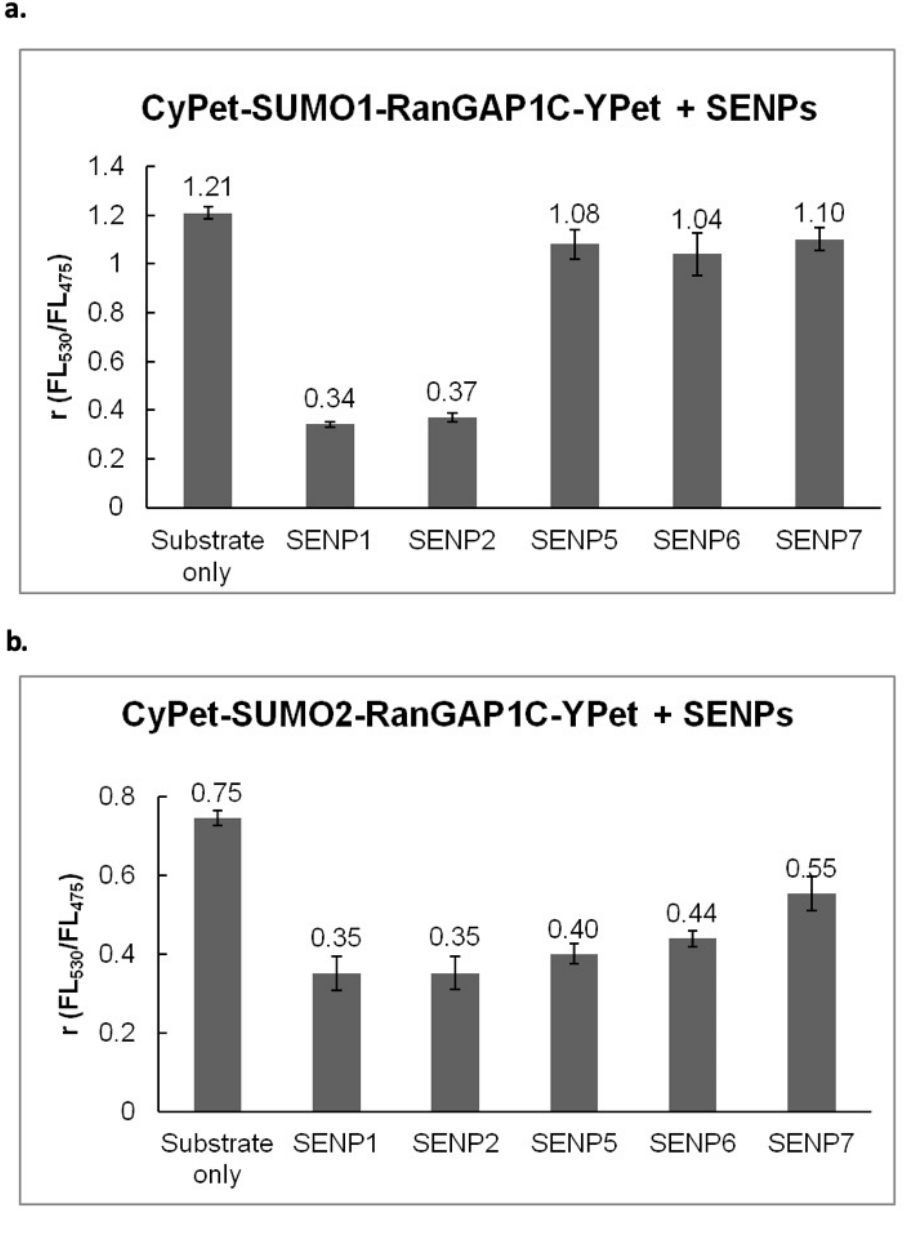
Figure 4. Characterization of SUMO1/2 deconjugation from RanGAP1C by SENP1/2/5/6/7C in developed FRET-based protease assay.